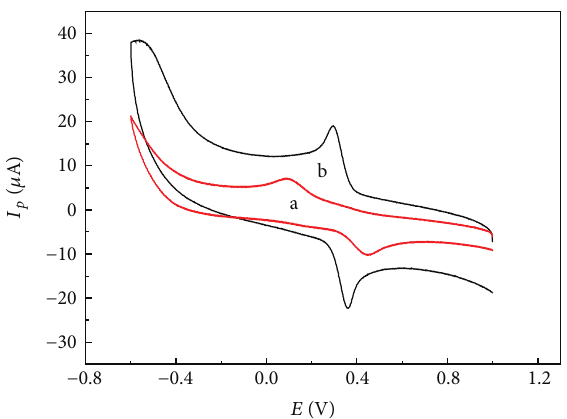
Figure 4: DPV for GCE (Curve a) and PLH/GCE (Curve b) for hydroquinone in H 2 SO 4